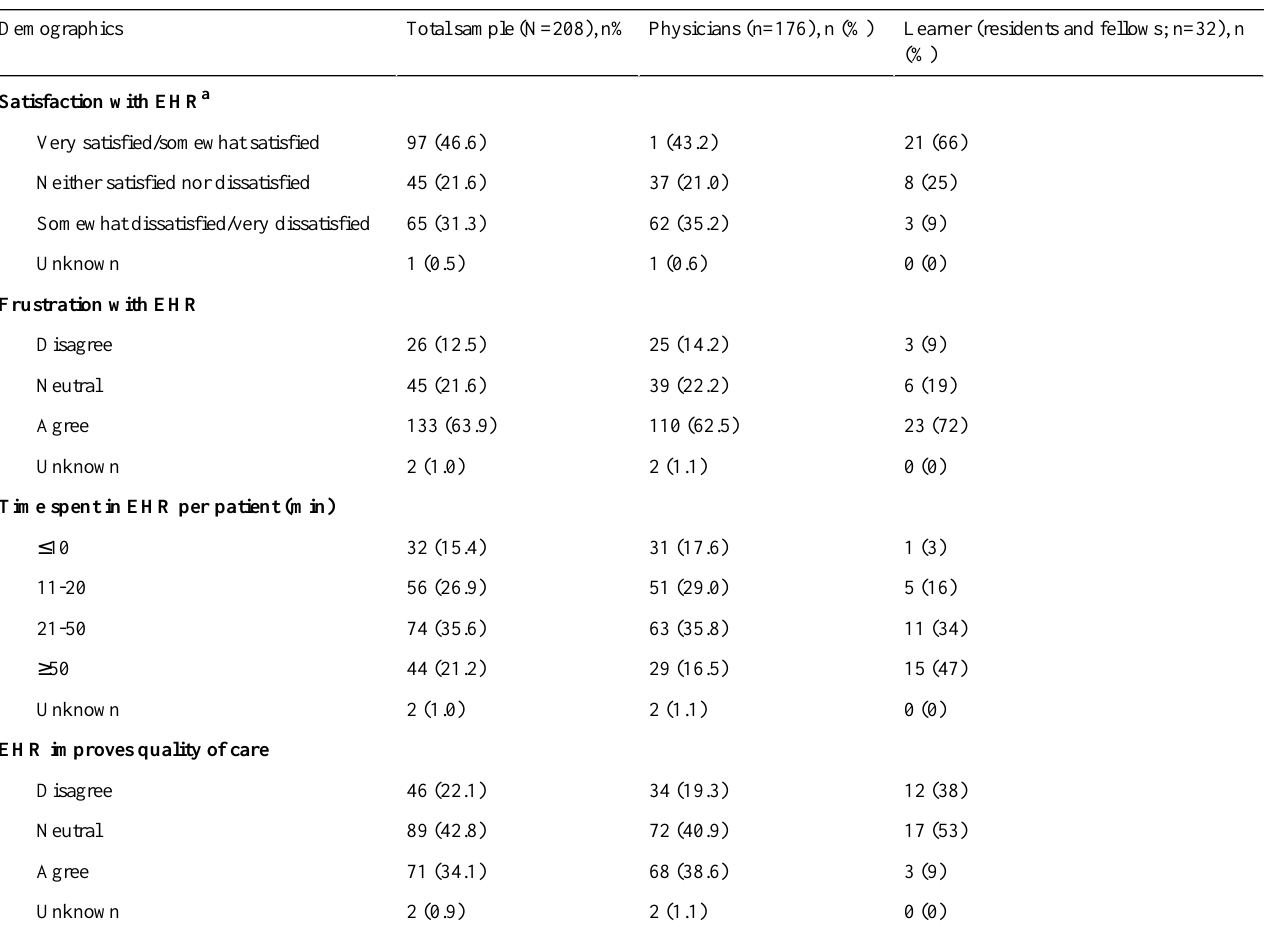
Table 4. Electronic health record factors, by experience